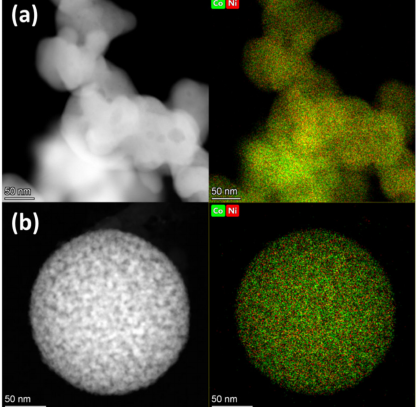
Figure 5. HAADF STEM and EDX elemental mapping of the reduced samples: Co2Ni1_W0 ( a ); Co2Ni1_W8 ( b ).